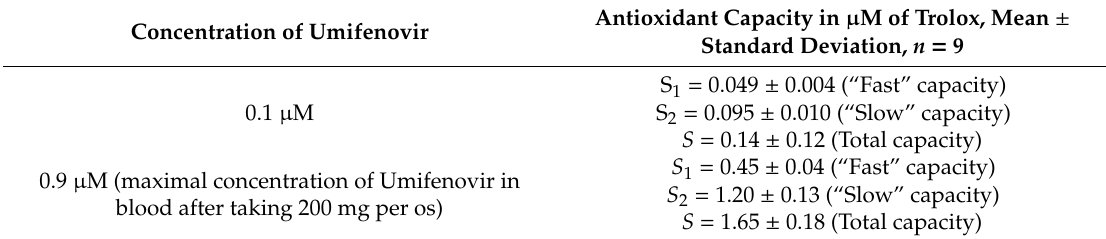
Table 1. The antioxidant capacity of Umifenovir relative to Trolox.